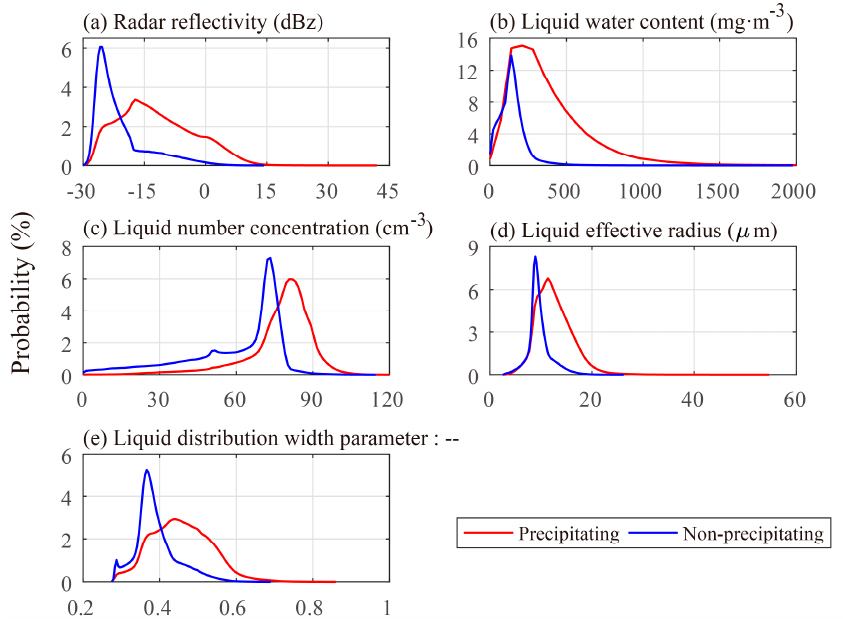
Figure 4. Probability density functions (PDFs) of microphysical characteristics of Sc clouds, including radar reflectivity ( a ); liquid water content ( b ); liquid effective radius ( c ); liquid number concentration ( d ) and liquid distribution width parameter ( e ) detected by CloudSat over EC. Red and blue lines represent the PDFs of microphysical characteristics in PS and NPS clouds, respectively.